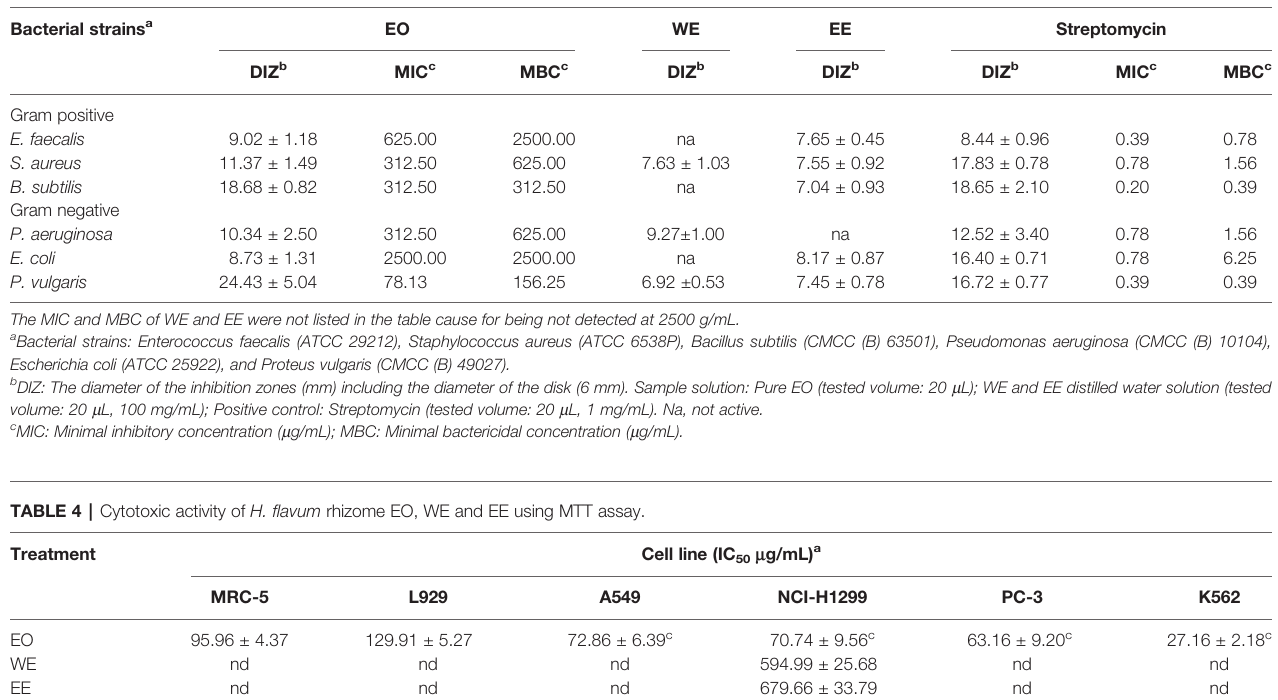
TABLE 3 | Antibacterial activity of H. fl avum rhizome EO, WE and EE. Bacterial strains a EO WE EE